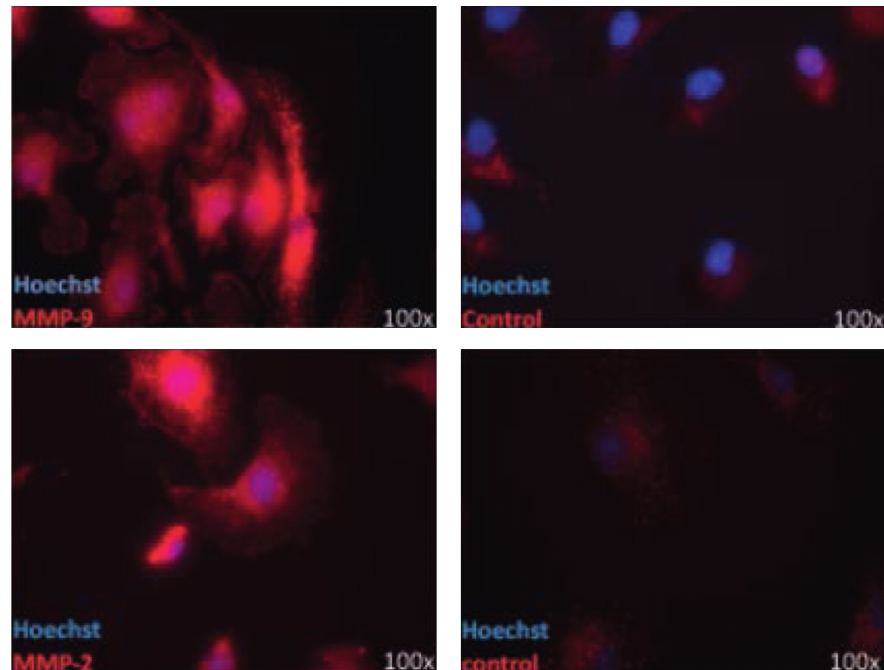
Figure 3: Immunohistochemistry of murine microglia, stained for MMP-2 and MMP-9. Microglia from CD11c GFP mice, fixed with PFA, treated with TBS and NGS, anti-MMP-2 (1:125) and anti-MMP-9 (1: 500); control: BSA and secondary